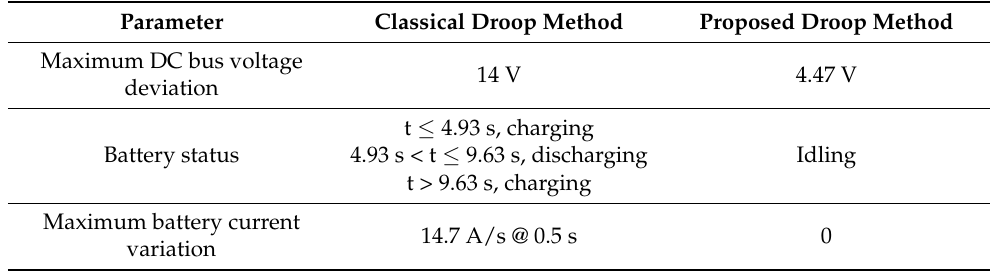
Table 7. Comparison among the proposed droop method and the classical droop approach for the SCES/battery